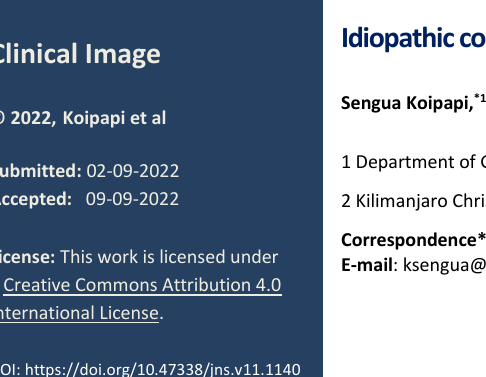
Primary lymphedema arises from abnormal lymphatic system development, which can be a complete absence of lymphatics or lymphatic hypoplasia.